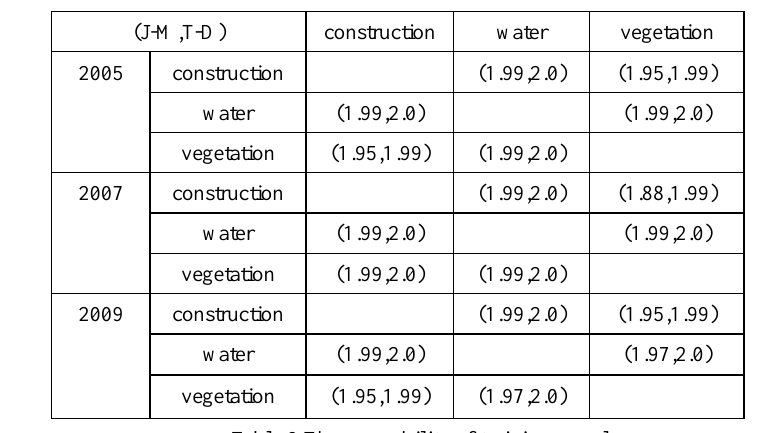
Table 2.The separability of training